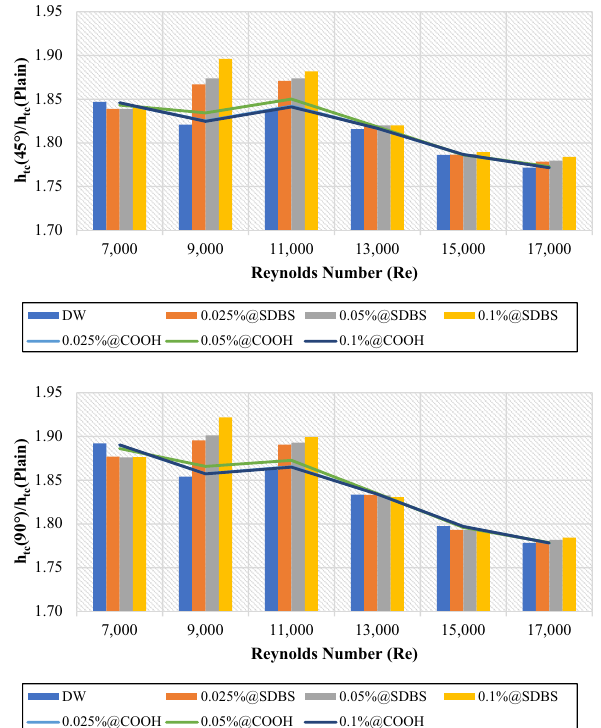
Figure 11. Heat transfer coefficient of (45° and 90° helix angles) relative to plain pipe versus Reynolds numbers for different